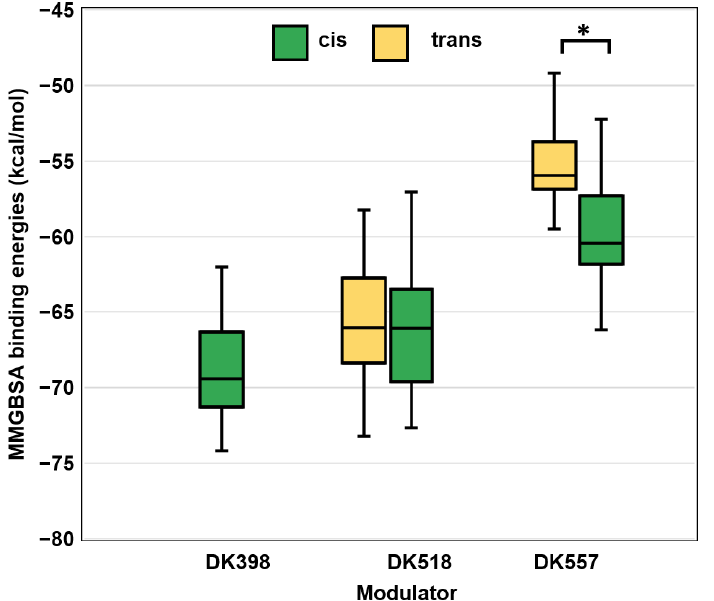
Figure 4. Box-and-whisker plot of the MM-GBSA binding energies of the photoswitchable molecules DK398, DK518 , and DK557 with CK1δ. The trans form of DK398 was not considered for MM-GBSA analysis due to its poor docking score. The interquartile range of binding free energies is shown in the bounded box with the horizontal line within the box denoting the median. The whiskers show the entire range of the binding free energies with the horizontal lines at the top and bottom representing the highest and lowest binding free energies, respectively. No significant difference in mean values between DK518 cis and trans forms was found (S tudent’s t -test, p > 0.05), whereas, for DK557 a significant difference was found (S tudent’s t -test, p < 0.05 or *) (for further statistical data, see SI Figure S14).